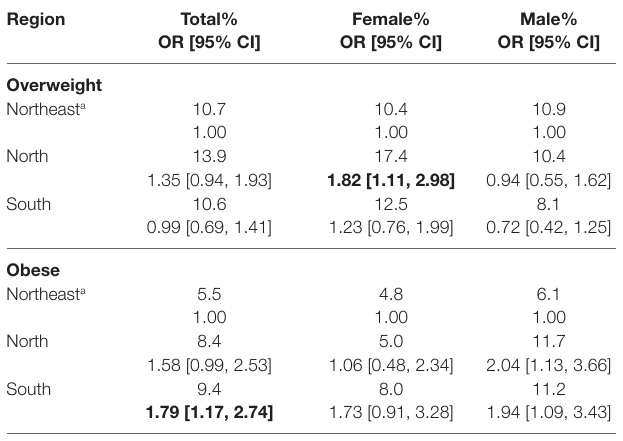
Boldface indicates a significant difference between groups after post hoc correction for multiple comparisons. OR, odds ratio; CI, confidence interval. a Reference group for comparisons between regions.